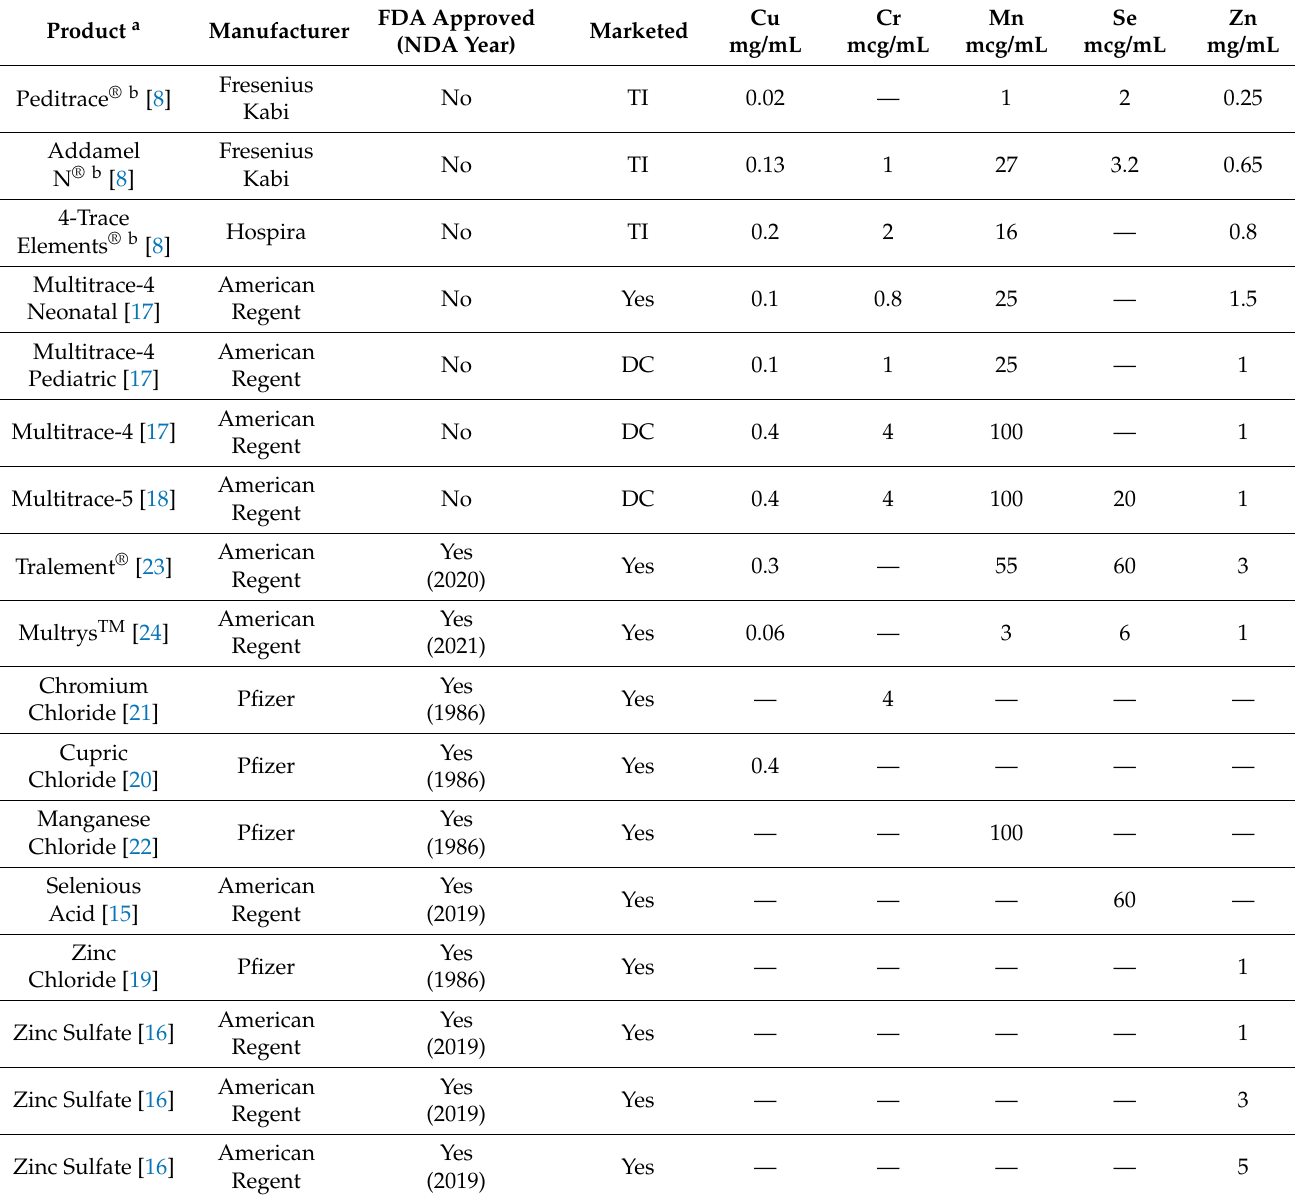
Table 2. Trace element PN products commercially marketed in the US over